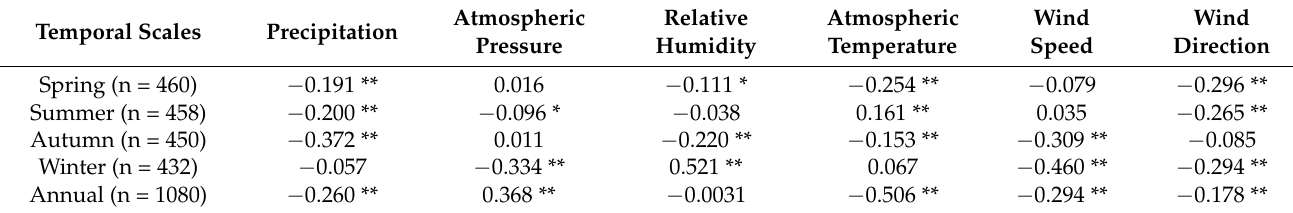
Table 4. Spearman correlations and multivariate progressive linear regression between PM2.5 and meteorological factors in